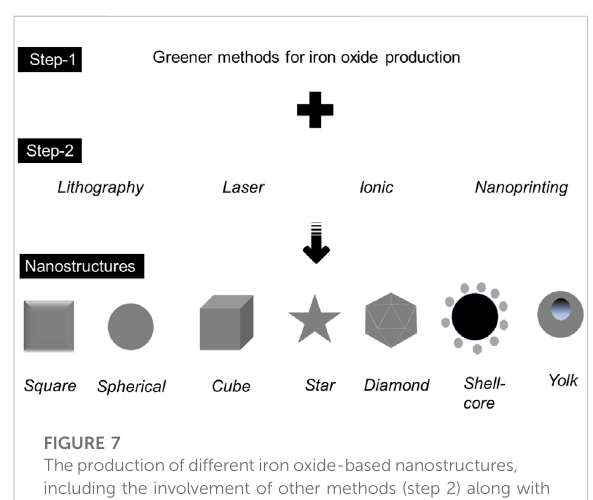
FIGURE 7 Theproductionofdifferentironoxide-based nanostructures, including the involvement of other methods (step 2) along with greener production (step